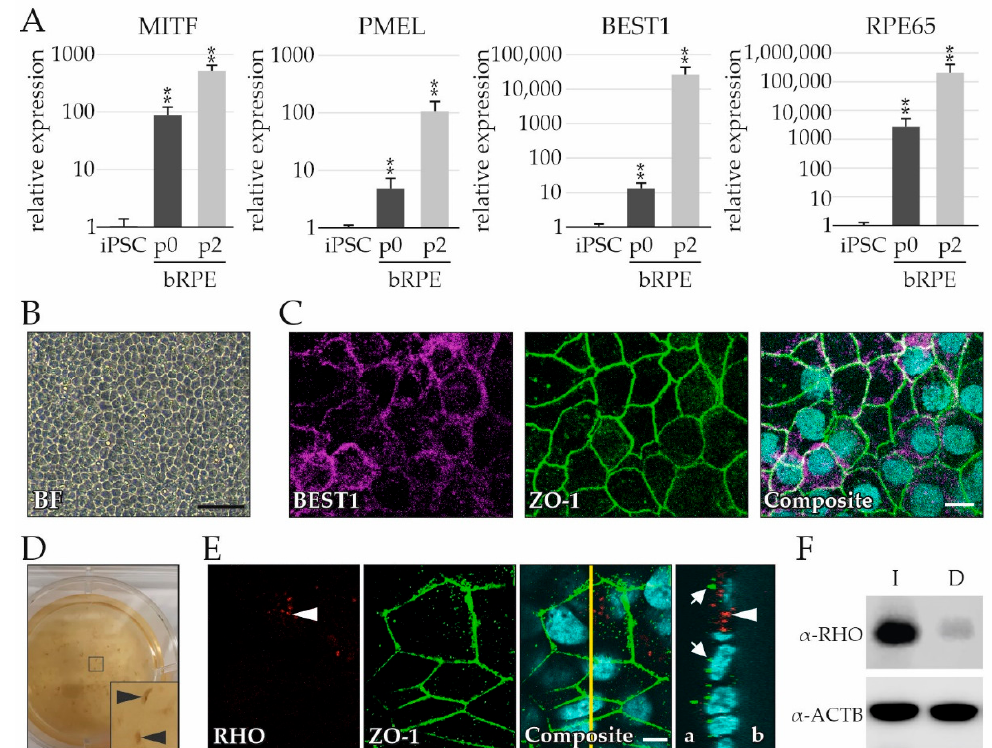
Figure 3. Byproduct RPE (bRPE) cells reveal characteristic retinal pigment epithelium (RPE) expression and typical phagocytotic photoreceptor outer segment (OS) activity. ( A ) Relative expression of RPE markers MITF, PMEL, BEST1, and RPE65 in bRPE cells during differentiation (p0, day 42) and after two passages (p2, day 105), in comparison to undifferentiated induced pluripotent stem cells (iPSCs). ( B ) Brightfield (BF) image of 105 ‐ day ‐ old bRPEs exhibiting cobblestone morphology. ( C ) 147 ‐ day ‐ old bRPE cells expressing BEST1 (an RPE marker) and ZO ‐ 1 (a tight junction marker), forming a honeycomb pattern. ( D ) Pigmented bRPE clusters could be identified during differentiation on day 42. A single well of a 6 ‐ well plate is shown. ( E ) After coculture with an RO, the 140 ‐ day ‐ old bRPE showed internalization of RHO ‐ positive photoreceptor OS. Z ‐ stacks demonstrate the intracellular localization of RHO ‐ positive OS (the vertical yellow line denotes the localization of the Z ‐ Stack; arrowhead: RHO ‐ positive photoreceptor OS; white arrows: ZO ‐ 1 ‐ positive tight junctions; a: apical; b: basal). ( F ) Porcine photoreceptor OS internalization by 168 ‐ day ‐ old bRPE is indicated by prominent RHO ‐ positive staining (lane labelled I, 37 kDa). Photoreceptor OS degradation by bRPE is indicated by weak RHO ‐ positive staining (lane labelled D). ACTB served as a loading control. Counterstaining was performed with Dapi dye. Scale bars: 10 μ m, ** p < 0.01 (Bonferroni ‐ corrected).